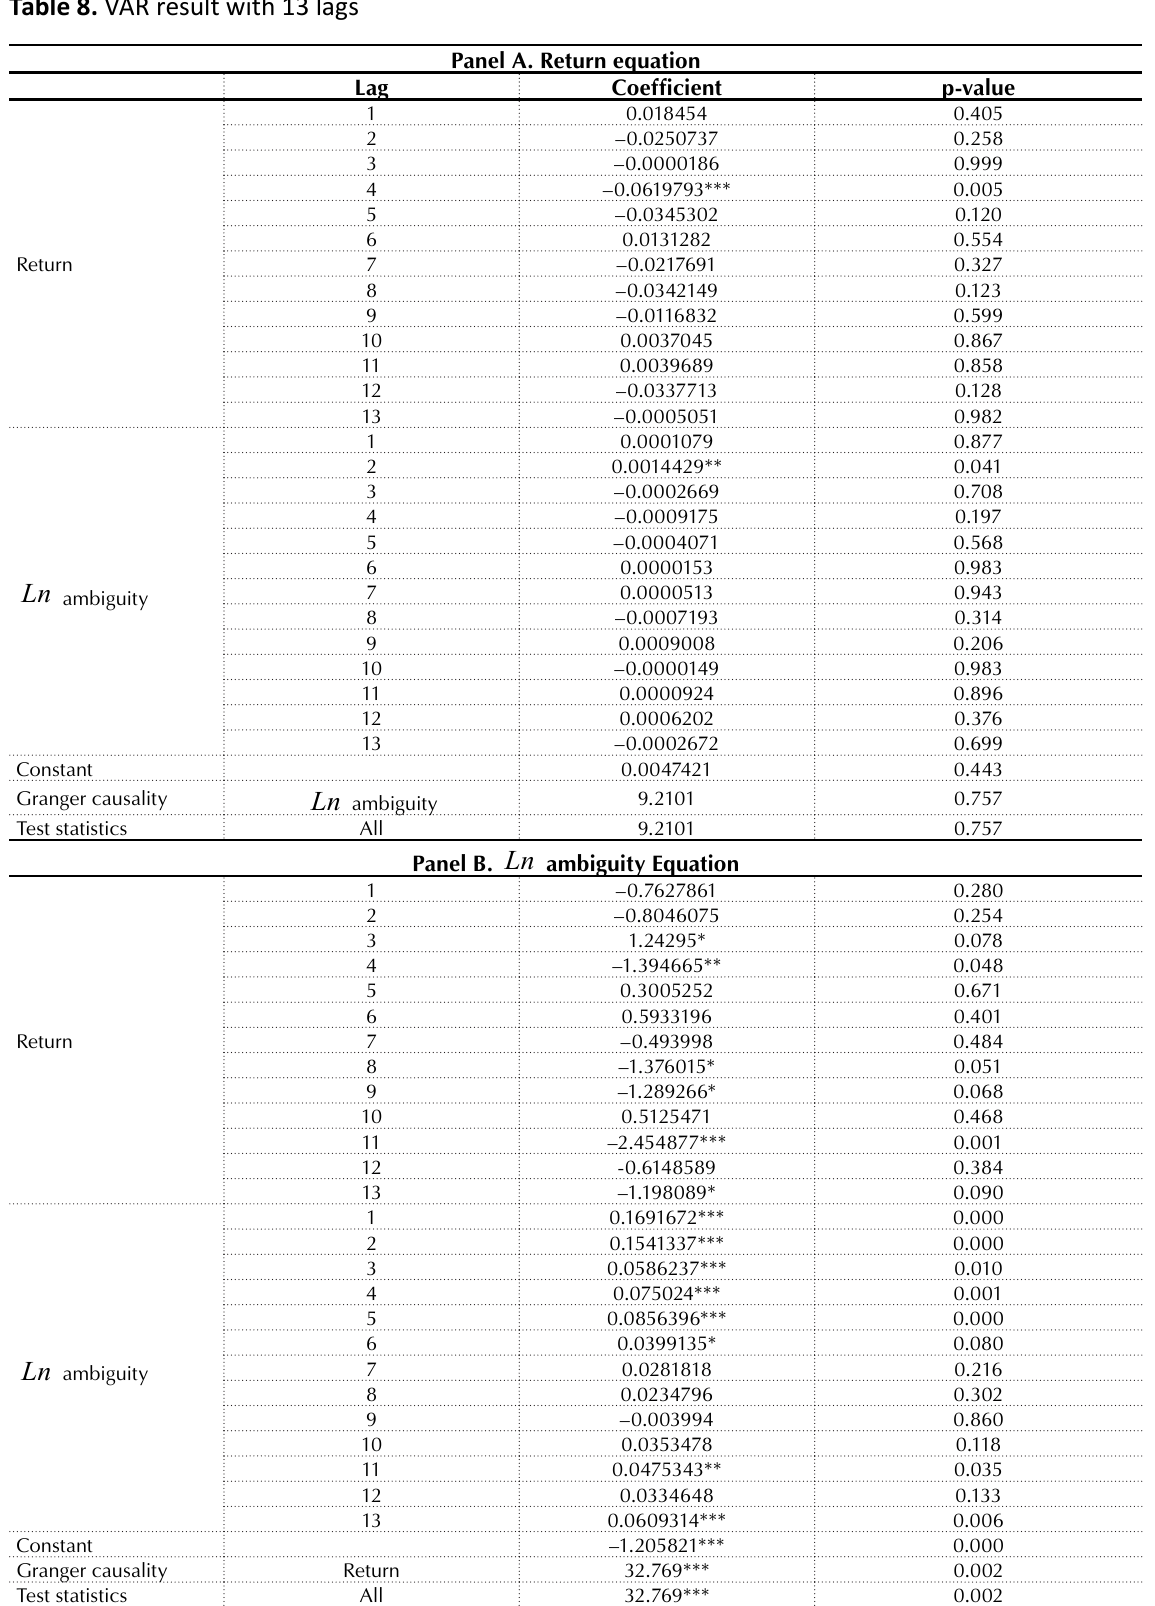
Table 8. VAR result with 13